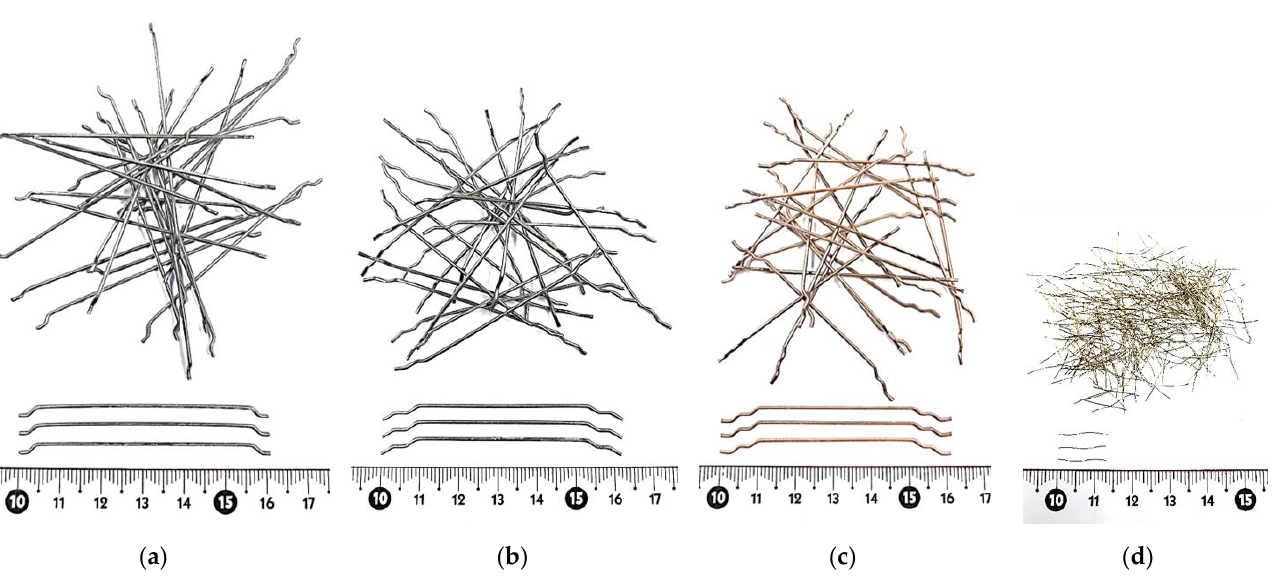
Figure 1. Types of steel fibres for normal, high- and ultra-high performance concrete: ( a ) 3D-fibre ( b ) 4D-fibre ( c ) 5D-fibre and ( d ) high-strength micro steel fibre.